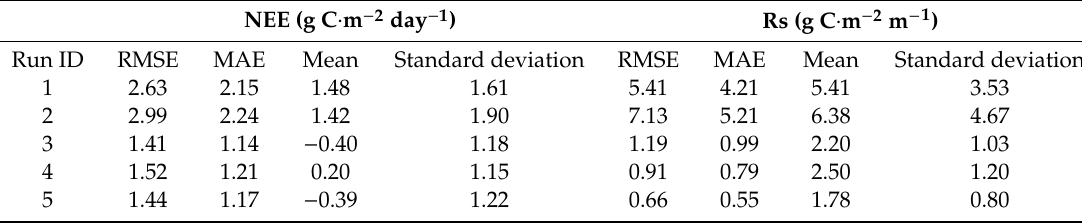
Table 4. Statistics of C flux simulation results for the Huitong subtropical Chinese fir